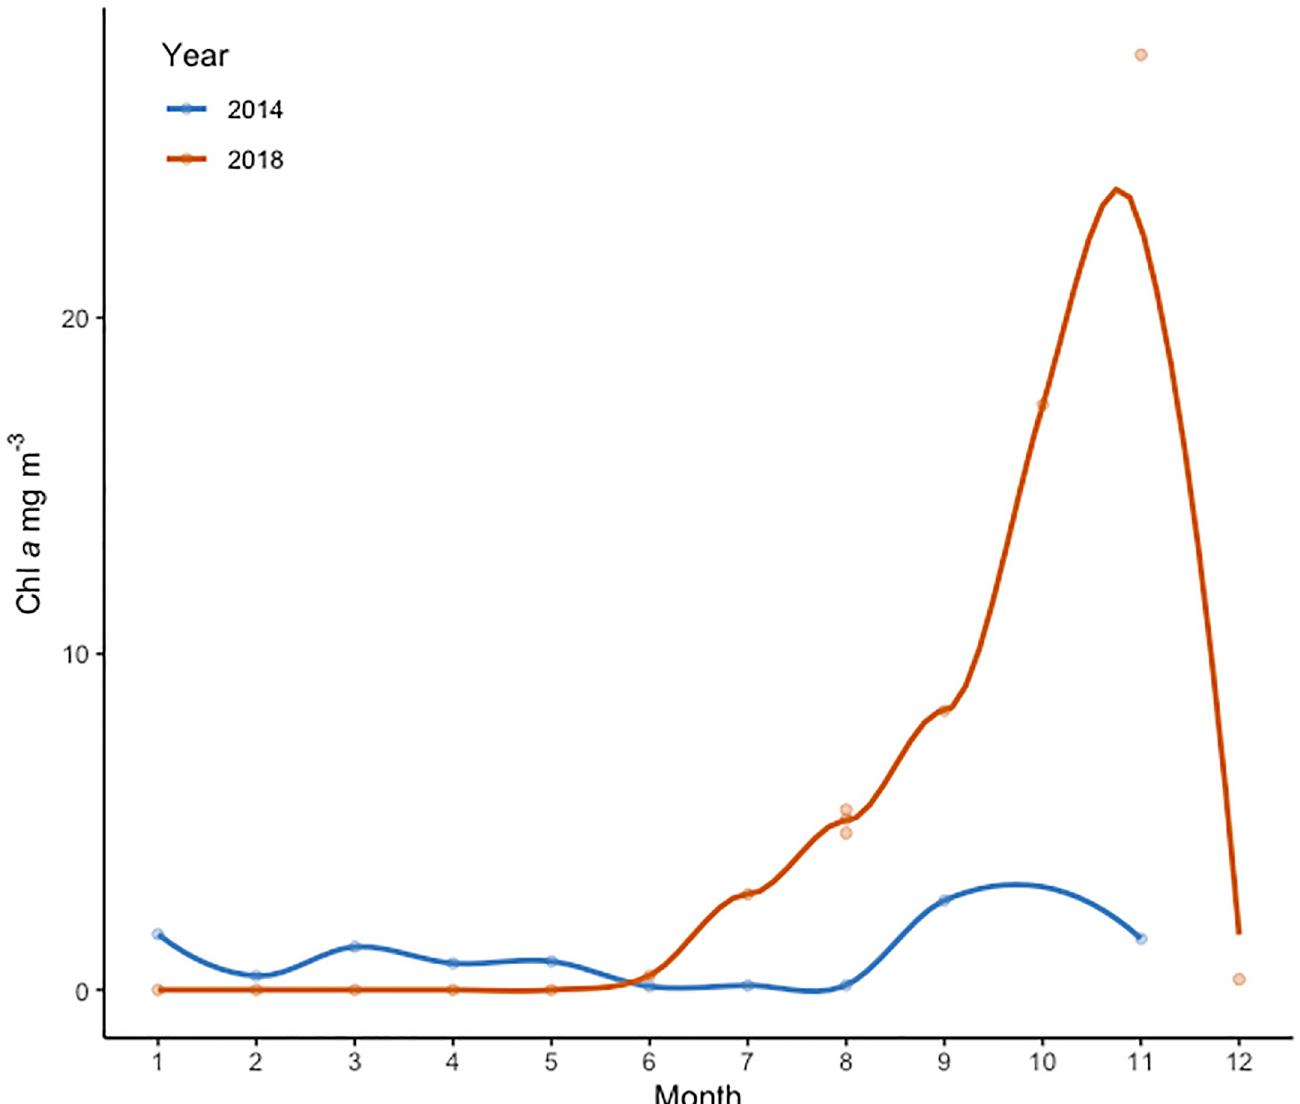
Fig 4. Seasonal dynamics of picocyanobacteria Chl a (mg L -1 ) in Lake V õ rtsja¨rv in 2014 (blue) and 2018 (red). Loess line is fitted on the data.